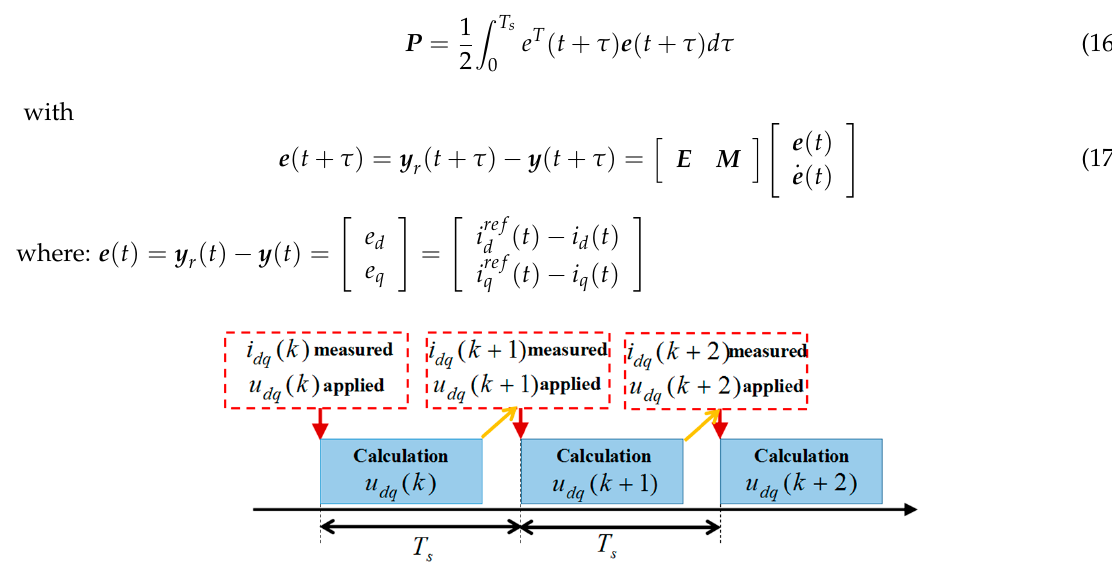
Figure 2. Logic diagram of a beat delay compensation using robust nonlinear predictive current control (RNPCC) method.